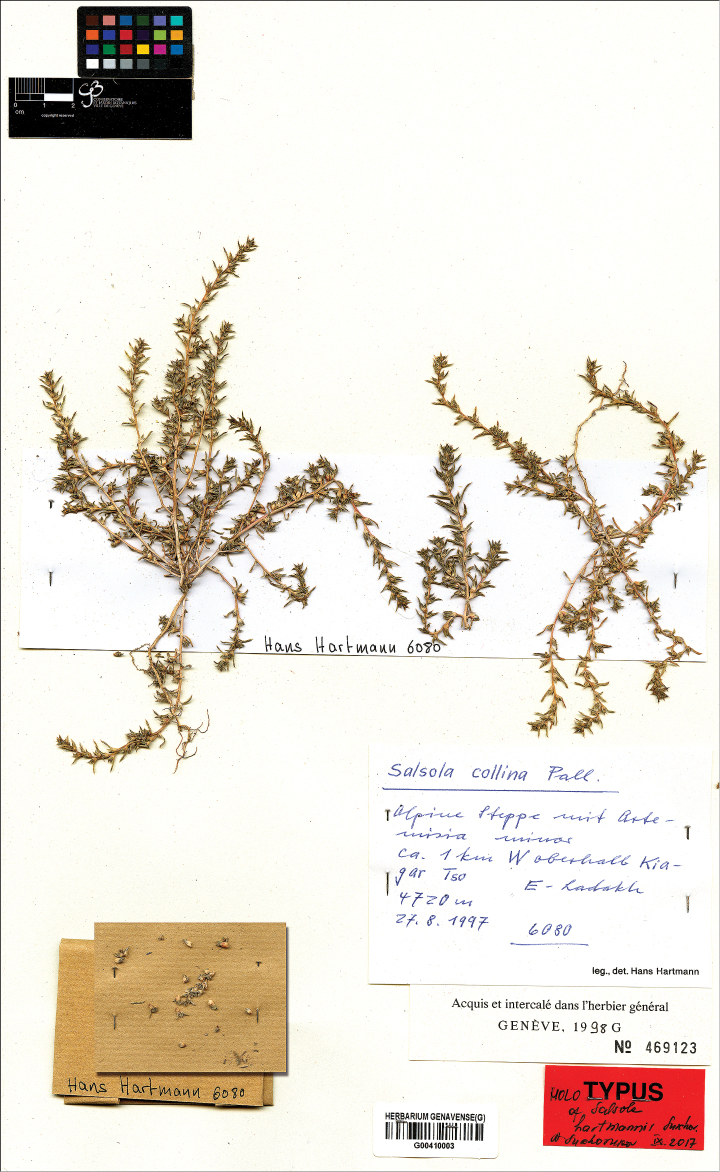
Holotype of Salsolahartmannii Sukhor. sp. nov. (G).